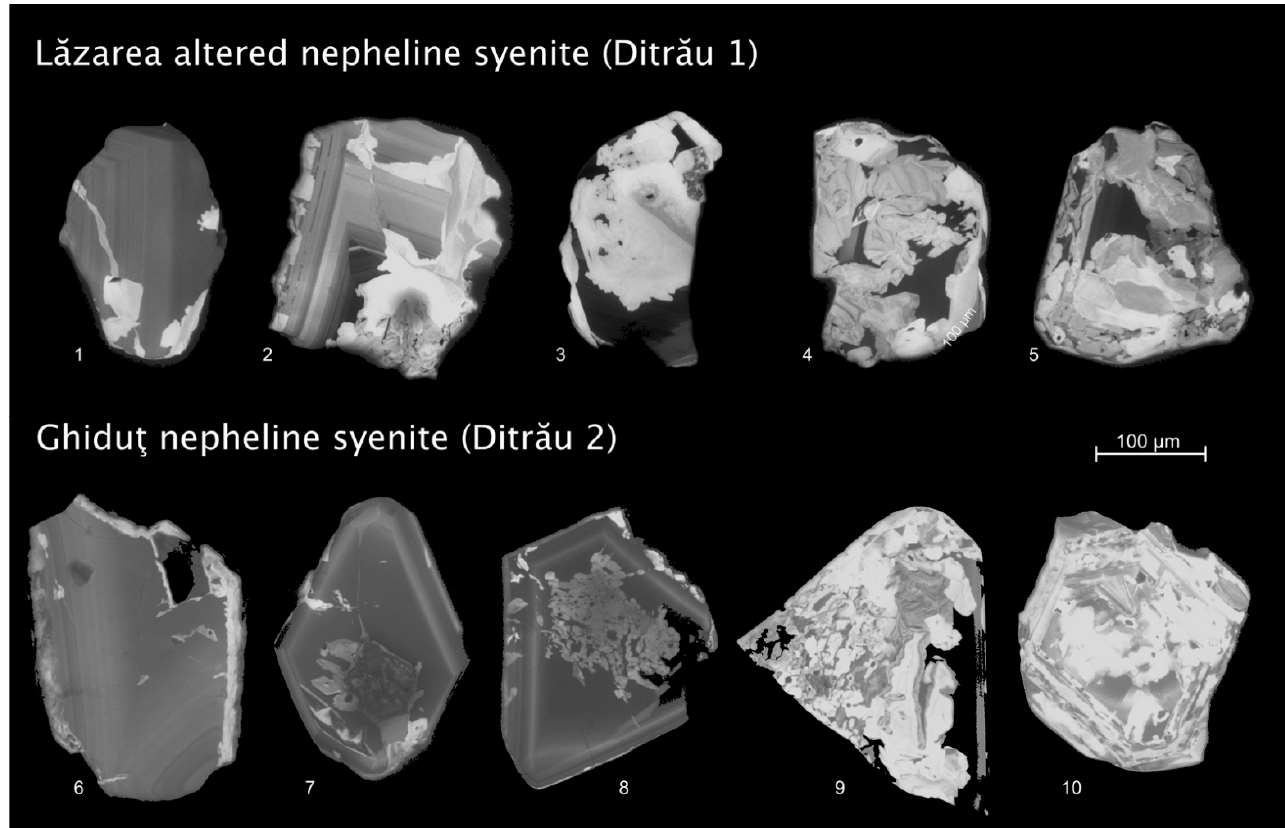
Figure 6. Zircon CL images showing crystal with a moderate (crystals 1, 6) to complete metaso- matic/hydrothermal overprinting or new growth (crystals 5, 10).